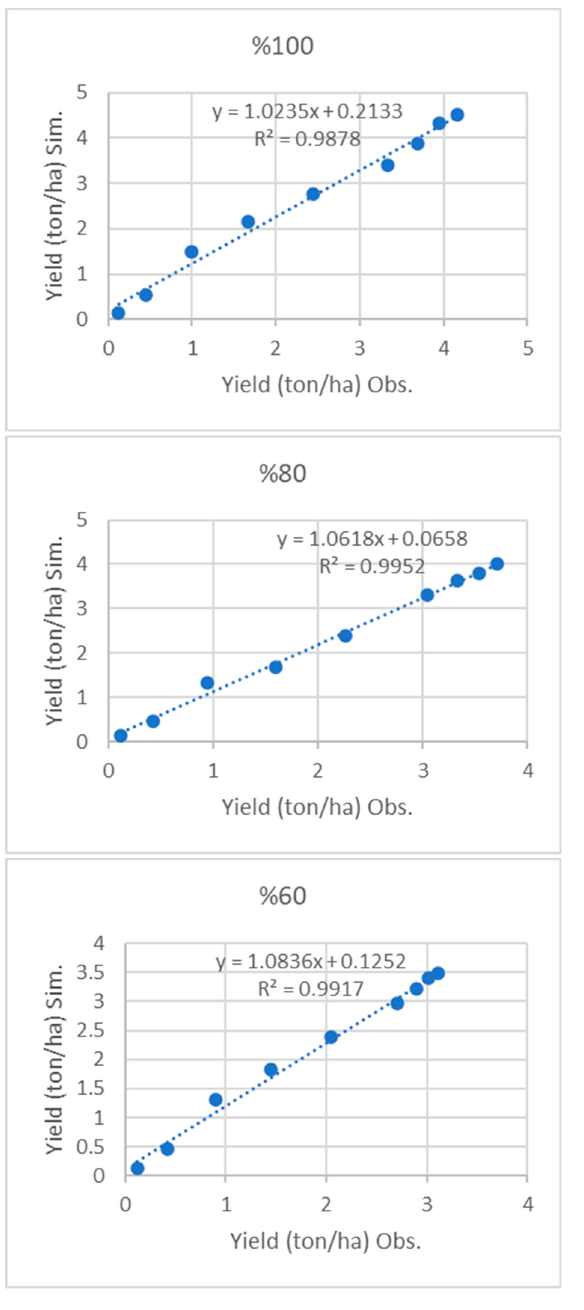
Figure 8. The results of model calibration for simulating the crop yield of the winter wheat crop under different irrigation conditions.